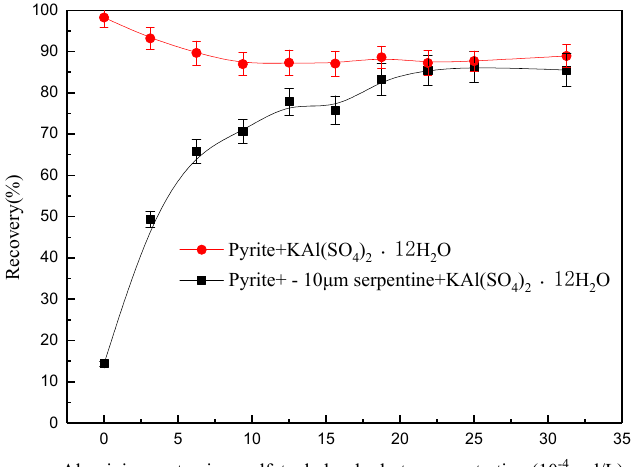
Figure 3. Flotation recovery of pyrite as a function of KAl(SO 4 ) 2 · 12H 2 O concentration ([PBX] = 3.75 × 10 − 5 mol/L, [MIBC] = 2 × 10 − 4 mol/L, pH = 9.0).